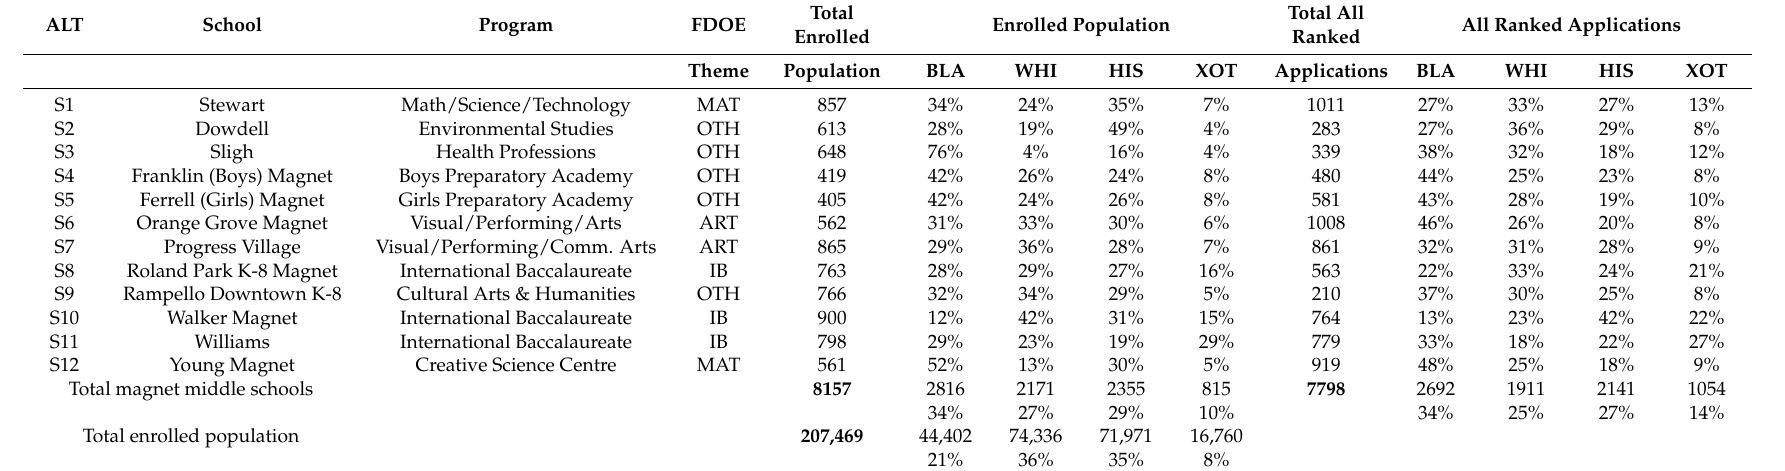
Table 2. SDHC magnet middle enrolled population and applications by race/ethnicity for the 2015–2016 academic